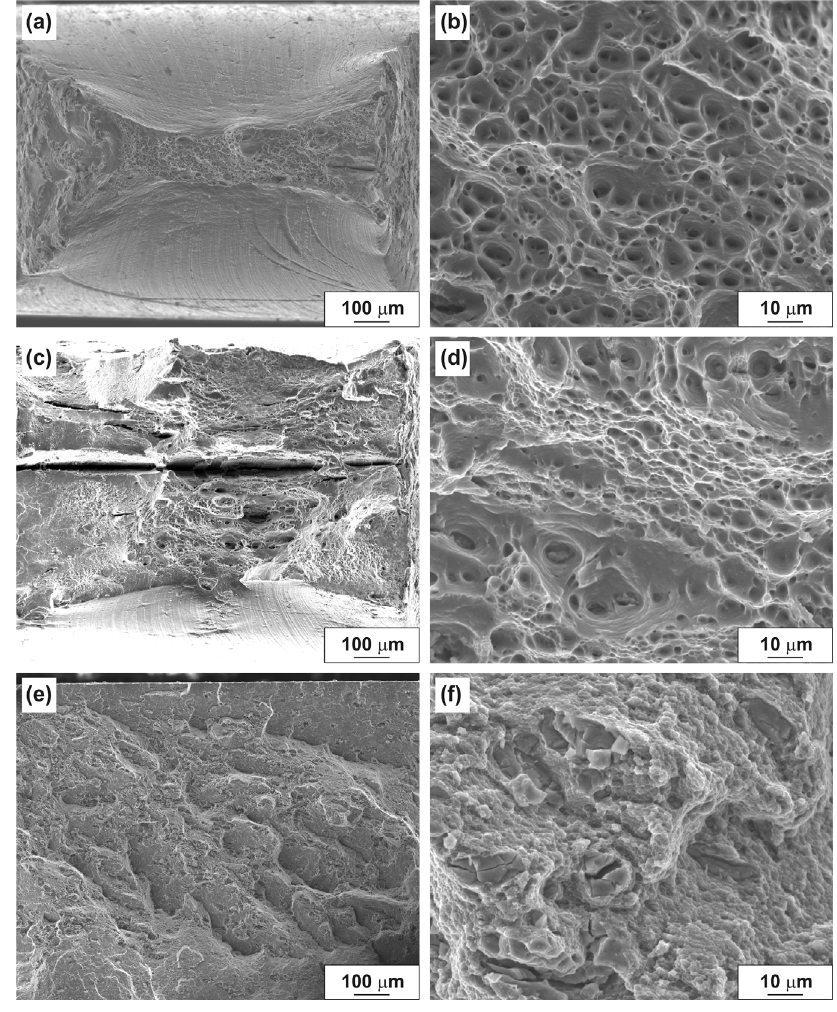
Figure 11. Fracture surfaces of the HPT-processed aluminum alloys after tensile tests: ( a , b ) Al–10% La; ( c , d ) Al–9% Ce; ( e , f ) Al–7% Ni. La; ( c , d ) Al–9% Ce; ( e , f ) Al–7%